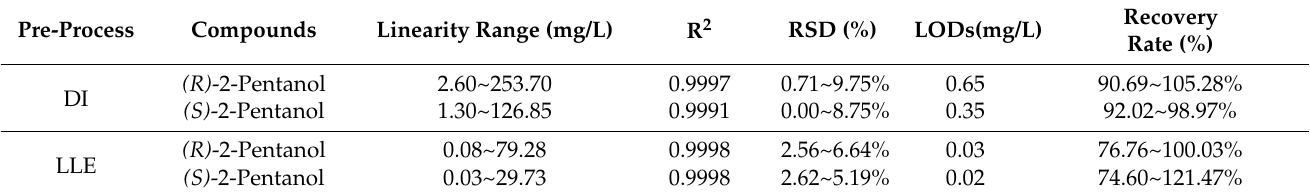
Table 3. Linear range, RSD, LOD, and recovery rate of 2-pentanol in GC-MS analysis.